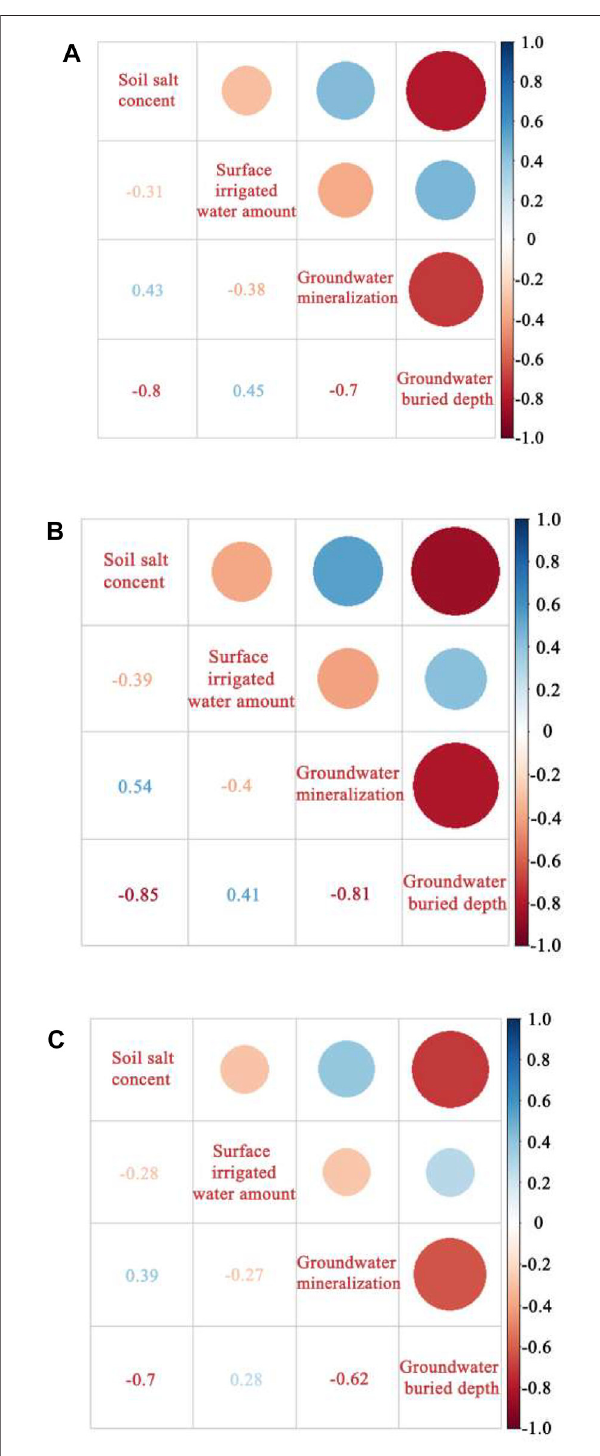
To verify the relationship between the increase rate of the soil salt content and the groundwater buried depth obtained by fi tting, the values of groundwater buried depths at the measured points in